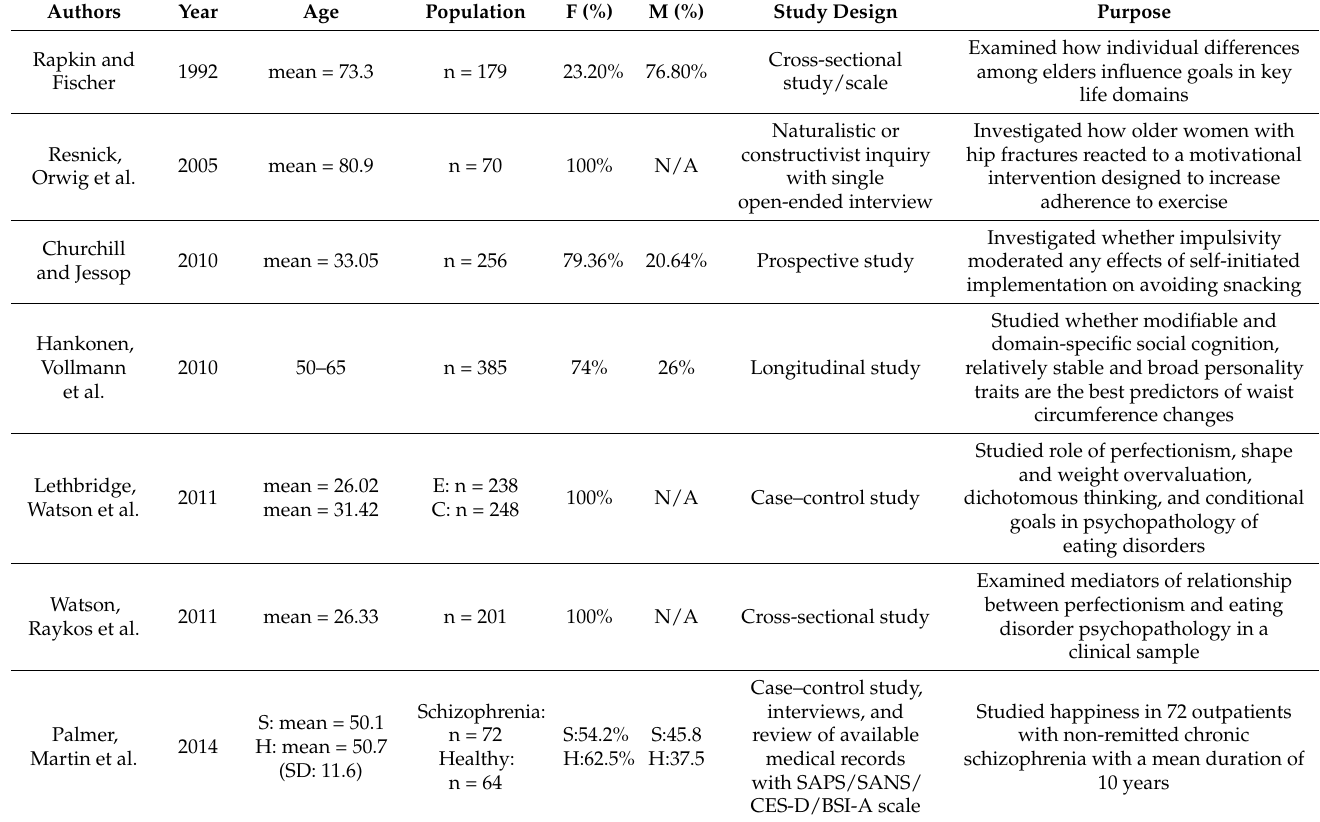
Table 1. Summary of the retrieved